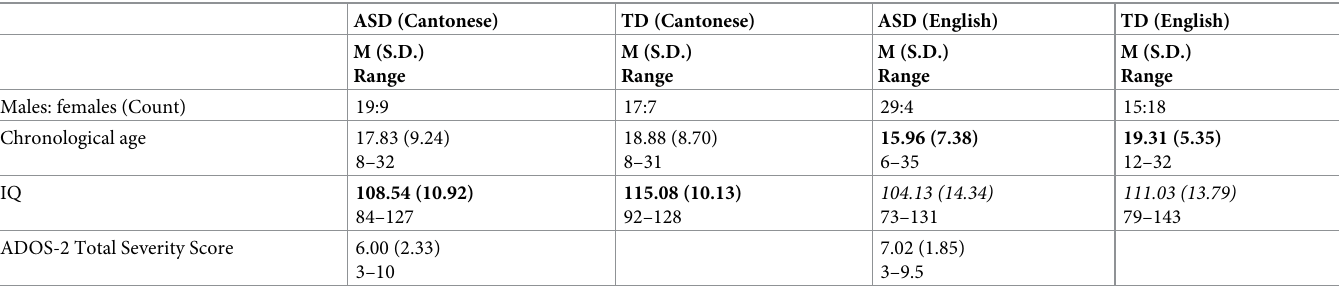
Table 1. Demographic